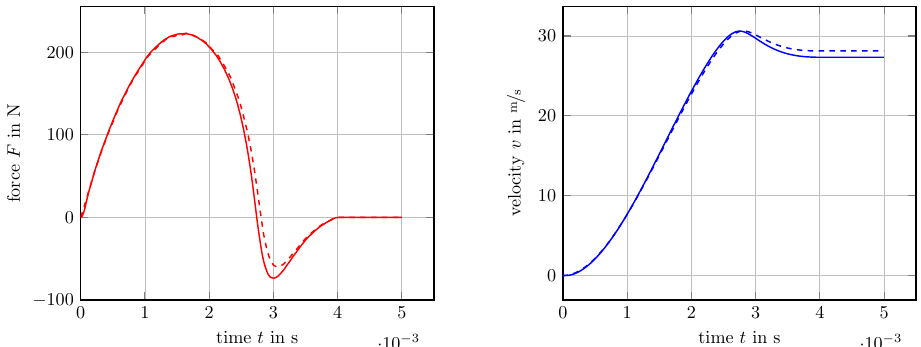
Figure 13. Magnetic force on the projectile ( left ) and its velocity ( right ). Dashed lines show results carried out with FEMM.